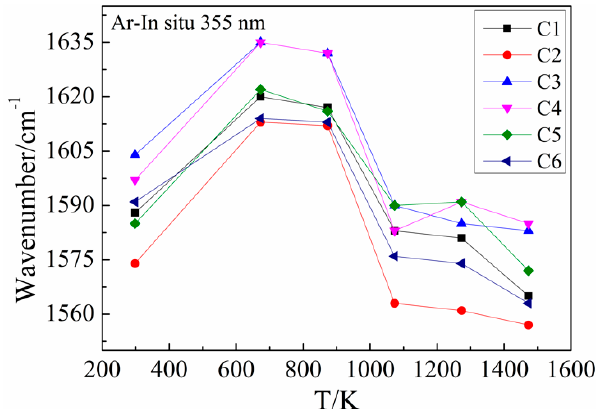
Figure 7. In-situ temperature dependence of the peak position of the G band for the samples pyrolyzed under an Ar atmosphere.